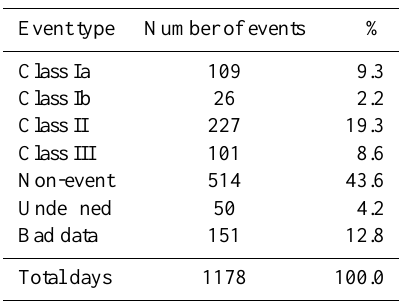
Table 2. Total number and percentage of events observed from June 2008 to June 2012.